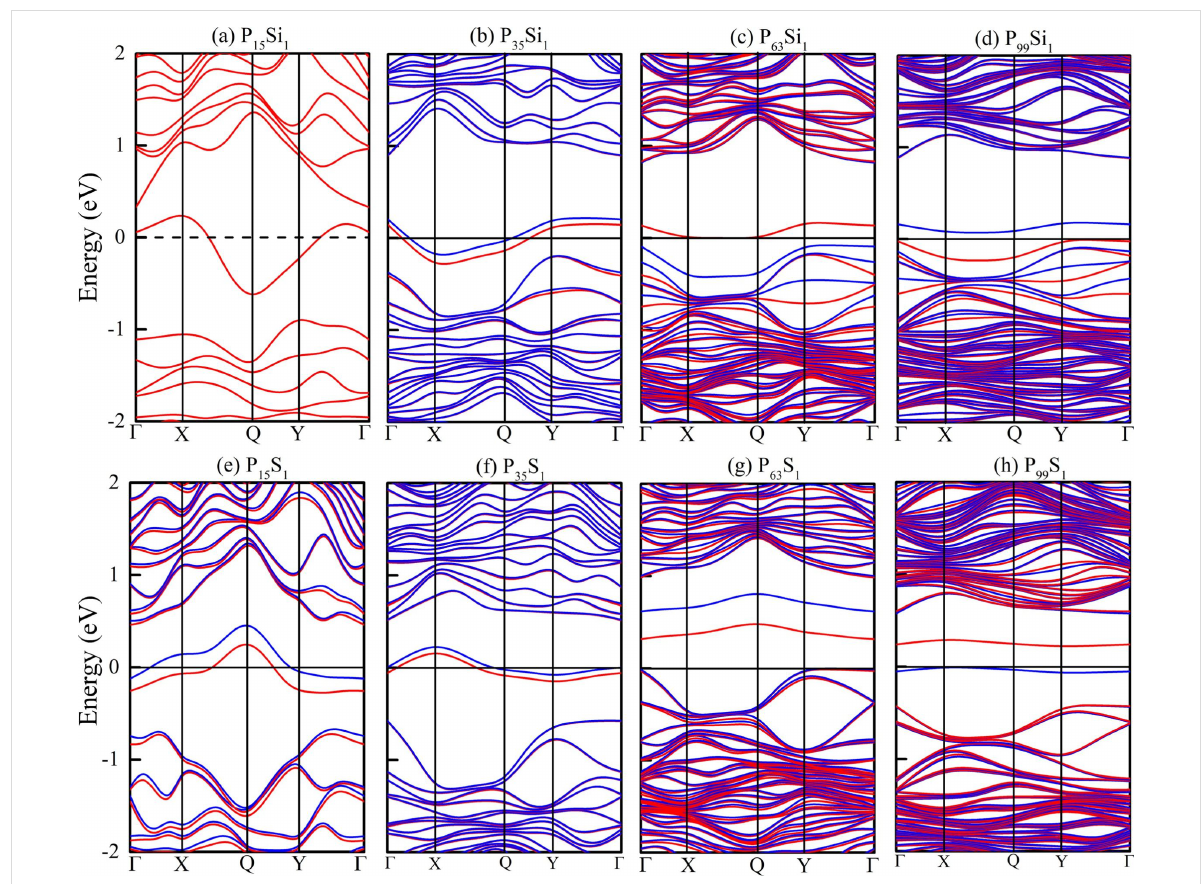
Figure 5: Band structures of Si- and S-doped phosphorenes as functions of the supercell size. (a–d) Band structures of Si-doped phosphorene with (a) 2 × 2 × 1, (b) 3 × 3 × 1, (c) 4 × 4 × 1, and (d) 5 × 5 × 1 supercell, respectively; (e–h) band structures of S-doped phosphorene with (e) 2 × 2 × 1, (f) 3 × 3 × 1, (g) 4 × 4 × 1, and (h) 5 × 5 × 1 supercell, respectively. The spin-up and spin-down energy bands are represented by red and blue lines,